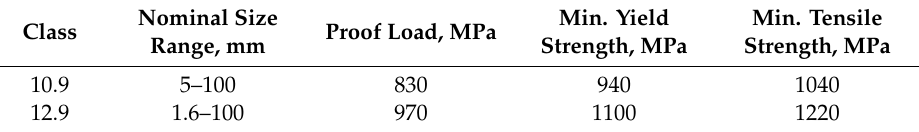
Table 1. Classes, size ranges and mechanical properties of bolts in heavy-duty